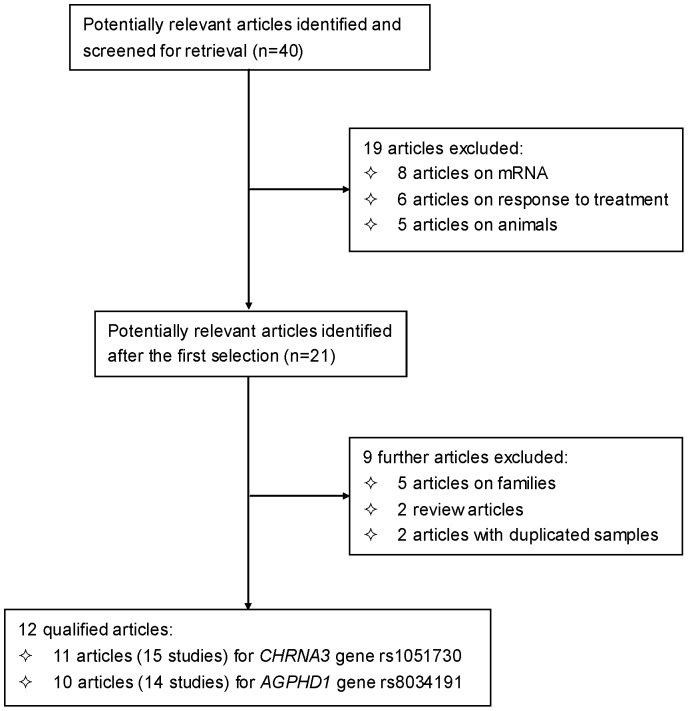
Flow diagram of search strategy and study selection.